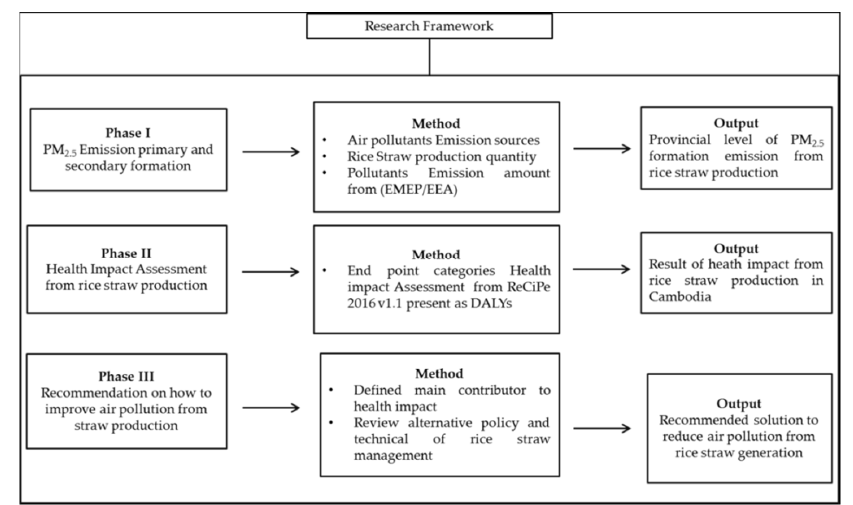
Figure 1. Research framework of endpoint impact from rice straw utilization.